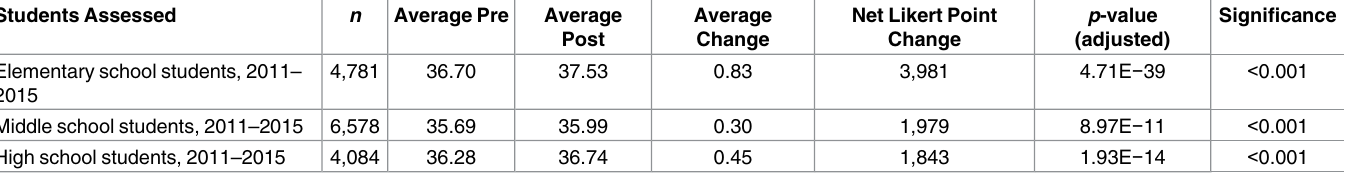
Table 2. Overall attitudes change following BioEYES exposure. Students Assessed